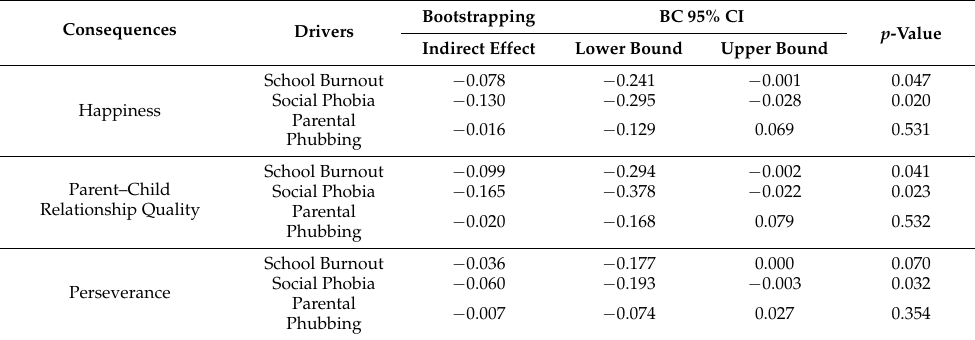
Table 6. Mediation